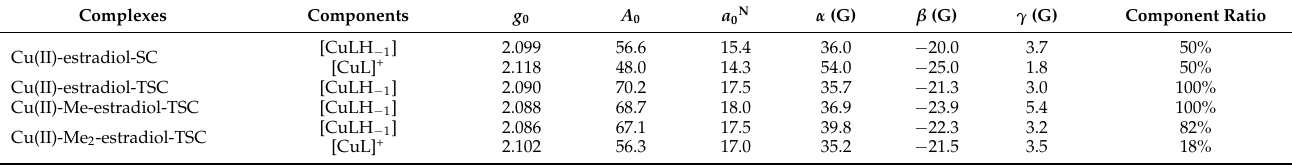
Figure 3. Room temperature solution EPR spectra (black) recorded for Cu(II) complexes dissolved in DMSO of ( a ) estradiol ‐ SC, ( b ) estradiol ‐ TSC, ( c ) Me ‐ estradiol ‐ TSC, ( d ) Me 2 ‐ estradiol ‐ TSC and simulated (red) spectra together with the obtained component spectra. Spectrum ( a ) was simulated with 50% [CuL] + and 50% [CuLH − 1 ], ( b ) and ( c ) with 100% [CuLH − 1 ] and ( d ) with 18% [CuL] + 82% [CuLH − 1 ]. Table 3. Isotropic EPR parameters obtained by the simulation of room temperature EPR spectra recorded in DMSO of Cu(II) complexes formed with estradiol-(T)SCs. The unit of the coupling values is 10 − 4 cm − 1 . The experimental errors were ± 0.001 for g 0 and ± 1 G for couplings and linewidth parameters.